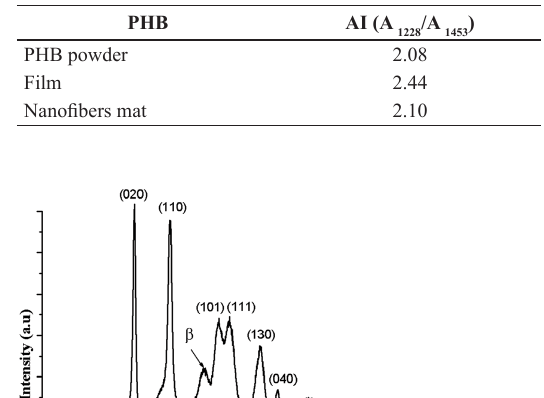
Table 3. Absorption indexes (AI) calculated through the ratio A